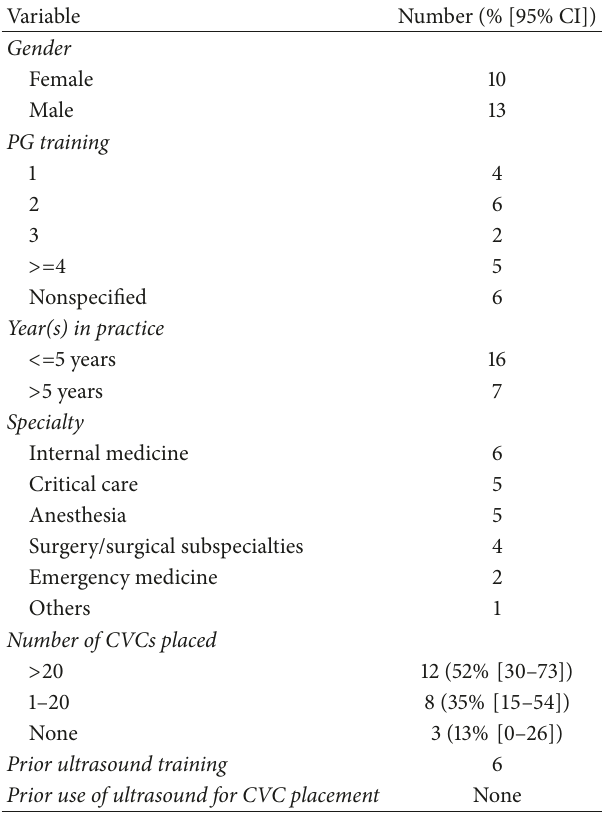
Table 1: The participants’ demographic data and past experience with ultrasound and performing CVC placement (𝑛 = 23)